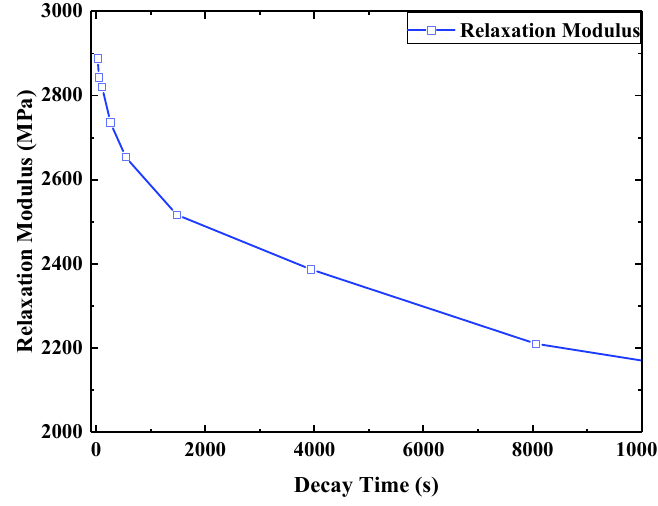
Figure 9. Master curve of the relaxation modulus at 30 °C.